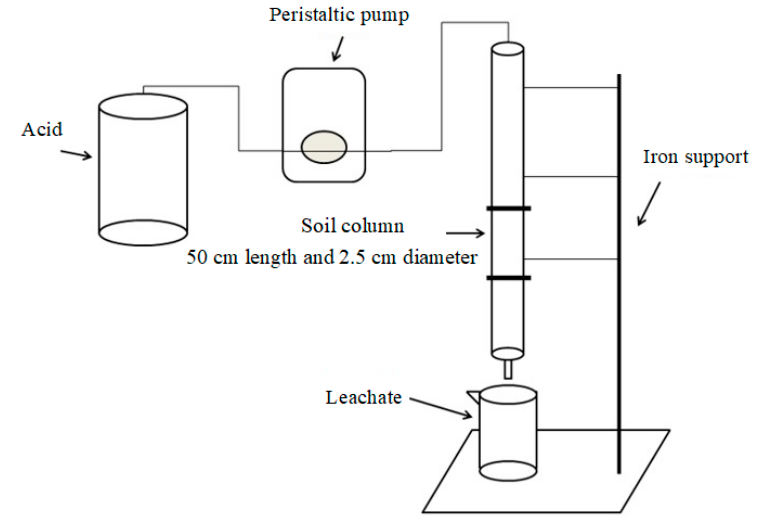
Figure 1. Diagram of the leaching device.